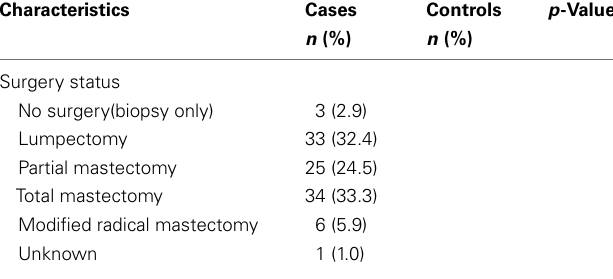
Table 2 | Patient and tumor